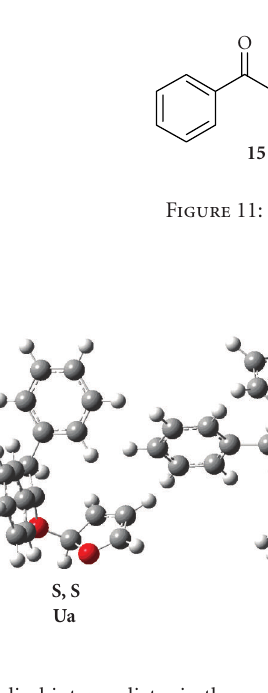
Figure 12: Biradical intermediates in the reaction between 15 and furan.